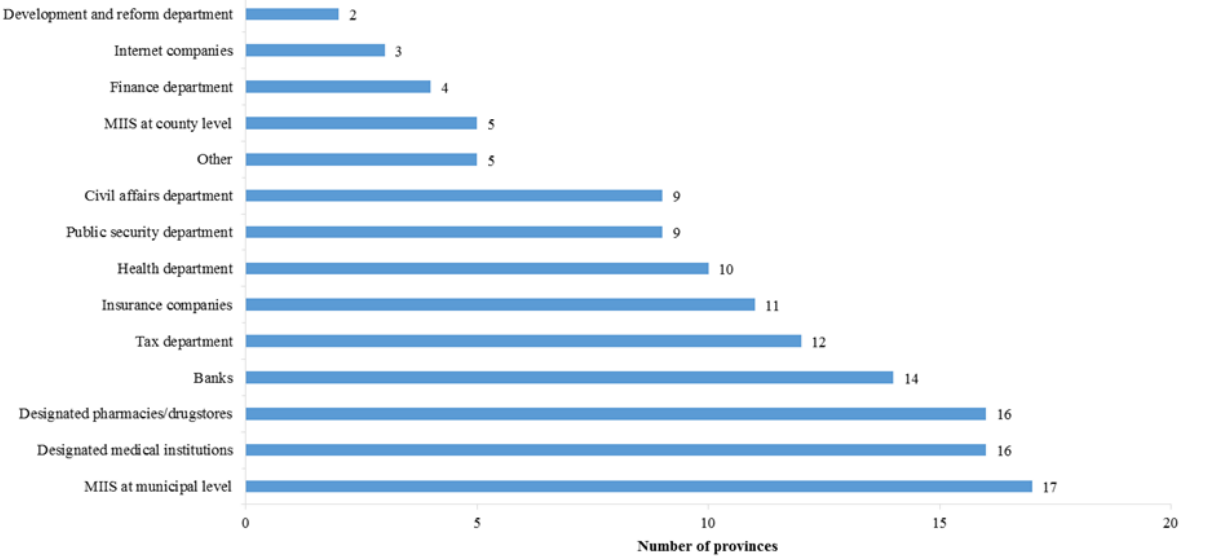
Figure 6. The interconnection between the medical insurance information systems (MIISs) and the surrounding information systems in each